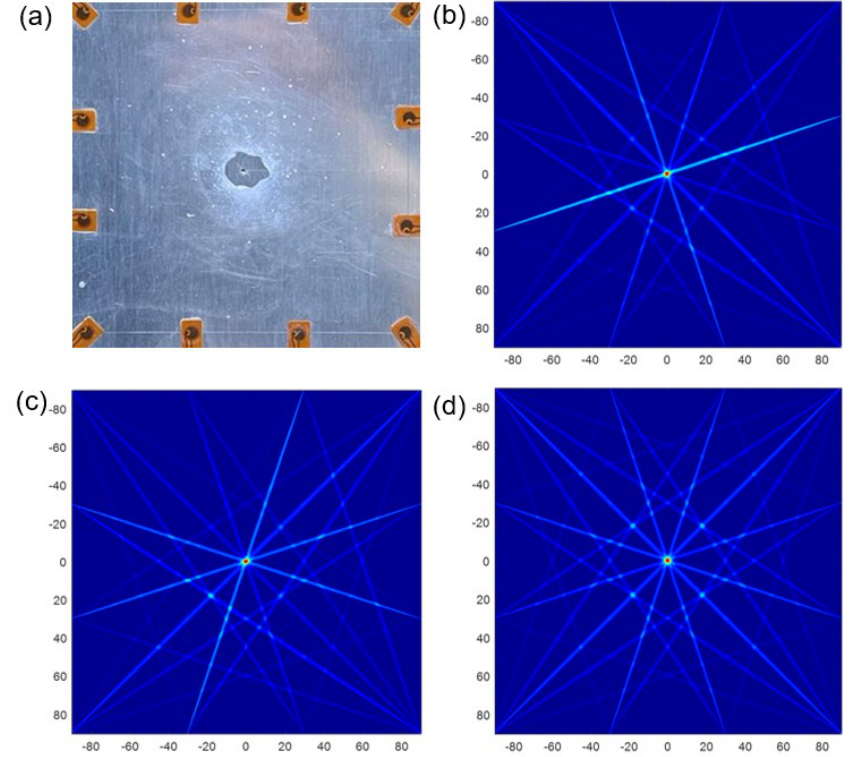
Figure 10. Comparison between real defect and simulated damage ( a ) real defect. ( b ) SDC. ( c ) RMSE. ( d ) E